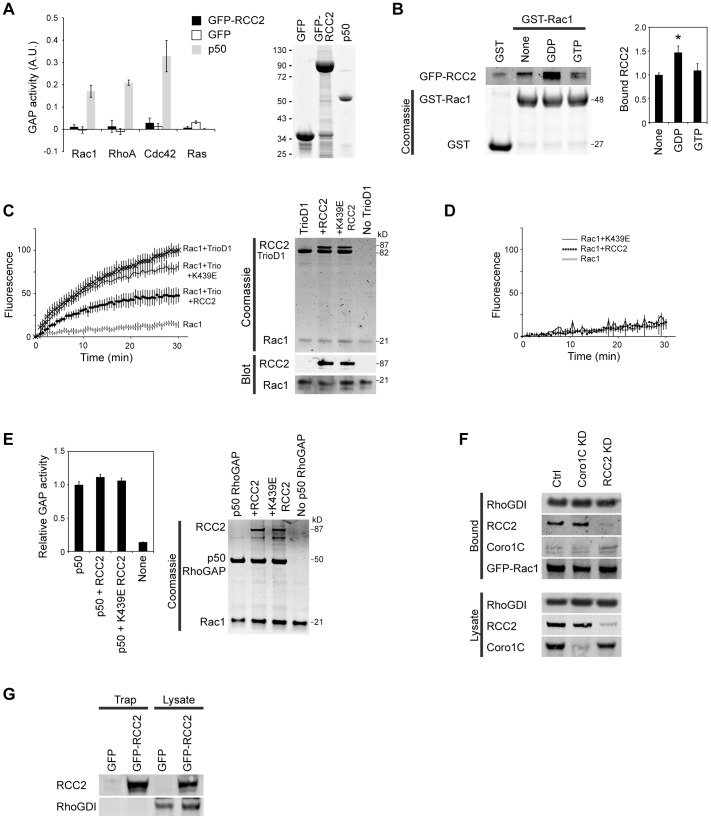
RCC2 inhibits GEF-mediated activation of Rac1. (A) Comparison of GTP hydrolysis by GTPases in the presence of GFP (negative control), p50RhoGAP (positive control) and GFP–RCC2, n = 4. The image is of a Coomassie-stained gel. (B) GFP–RCC2 from 293T lysates bound preferentially to GDP-loaded, rather than nucleotide-free or GTPγS-loaded GST–Rac1, n = 7. *P<0.05 (ANOVA). (C,D) GFP–RCC2, but not the RCC2-K439E mutant, inhibited TrioD1-mediated loading of mant-GTP on to Rac1 (C), but had no effect on spontaneous GTP loading (D), n = 12 for each. (E) GFP–RCC2 failed to inhibit p50RhoGAP-catalyzed GTP hydrolysis by Rac1, n = 12. (F) GFP–Rac1 was precipitated by GFP-Trap from control, RCC2-knockdown and Coro1C-knockdown MEF lysates. Co-precipitated RhoGDI, RCC2 and Coro1C were detected by western blotting, n = 4. (G) GFP–RCC2 was precipitated by GFP-Trap and blotted for RhoGDI and RCC2. n = 4. For A and C–E, tagged RCC2 and TrioD1 proteins were purified from 293T cells by GFP-Trap and relative protein loading was demonstrated by Coomassie-stained gel or western blotting. Results are mean±s.e.m.